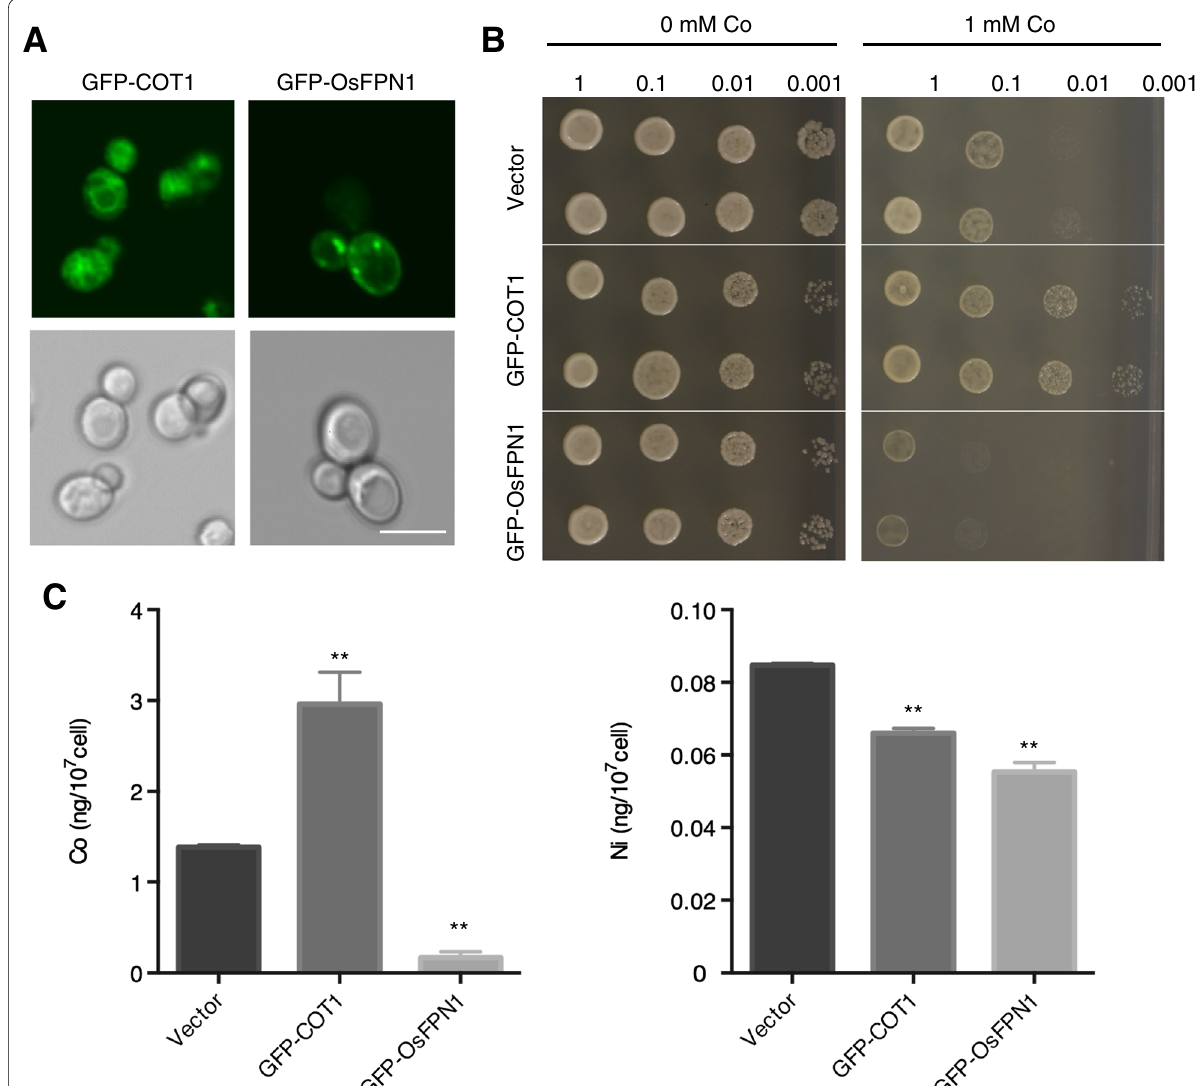
Fig. 6 Functional characterization in yeast. A GFP-COT1 and GFP-OsFPN1 localization in the cot1 yeast mutant. Bar 10 µm. B High Co tolerance = assay of yeast used in A . Yeast cells were adjusted to the indicated OD and spotted on SD-uracil medium containing 0 or 1 mM of Co. Images were captured after 2 d of incubation. C Co and Ni concentration in cot1 expressing GFP-COT1 and GFP-OsFPN1 . Yeasts were incubated with 50 µM of Co or Ni for 1 h, and Co and Ni were determined by ICP-MS. n 3–6. Dunnett’s test compared to the vector, ** p < =